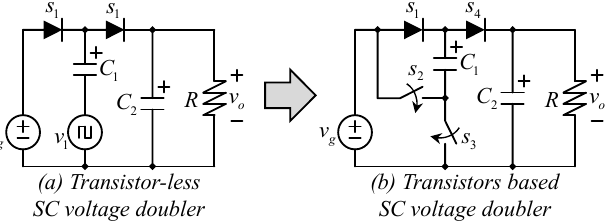
Figure 8. Switched-capacitor voltage doubler, the simplest configuration of the converter in Figure 6, ( a ) with an auxiliary pulsating signal and ( b ) based on two transistors and two diodes.